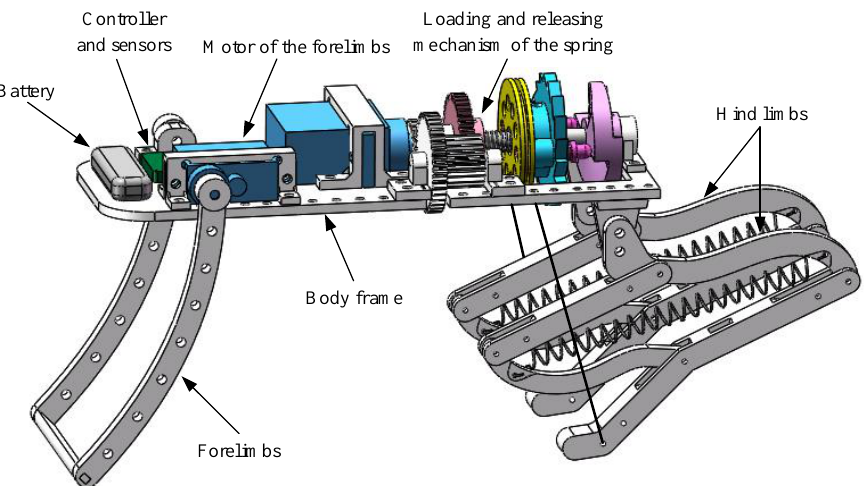
Figure 14. 3D model of the overall structure of the robot.